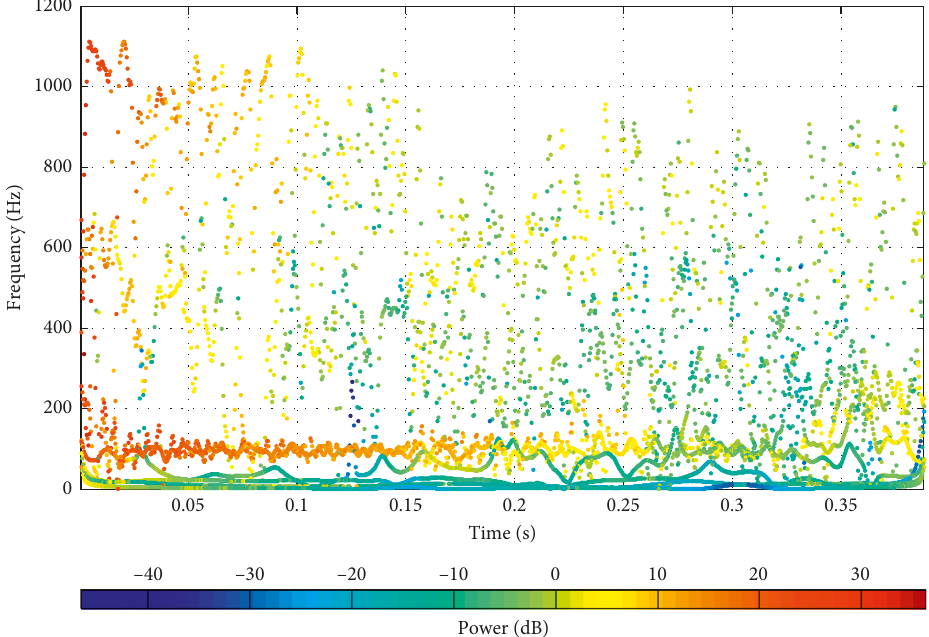
2 (cid:31) 1072Hz and (b) f 1 (cid:31) 101Hz.